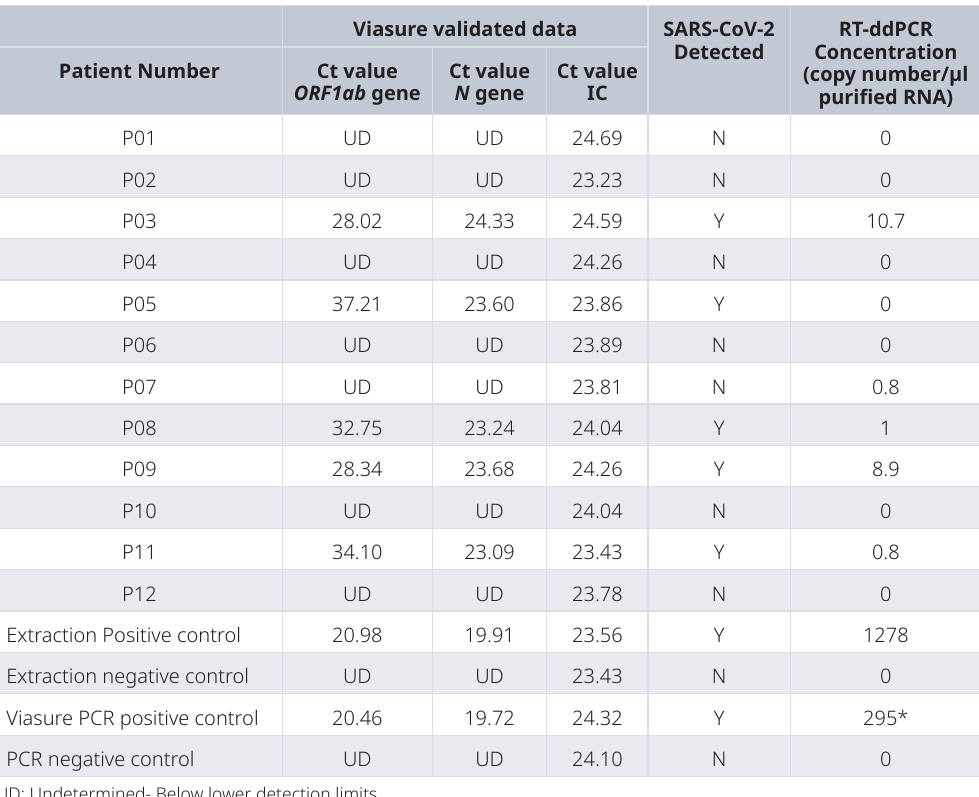
Table 4. Hospitalised COVID-19 positive patient stool sample results using the Viasure Real-Time PCR SARS-CoV-2 detection